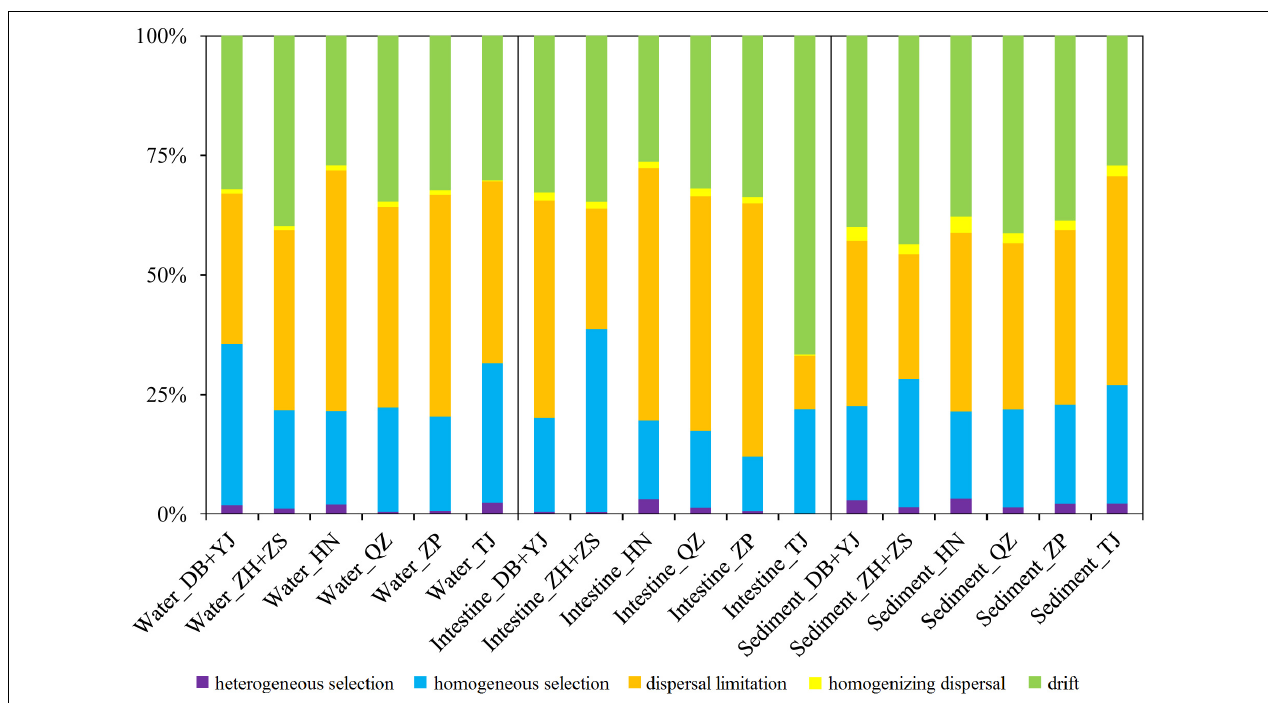
FIGURE 4 | The contribution of ecological processes on the microbial assembly of water, shrimp intestine, and sediment habitats of six